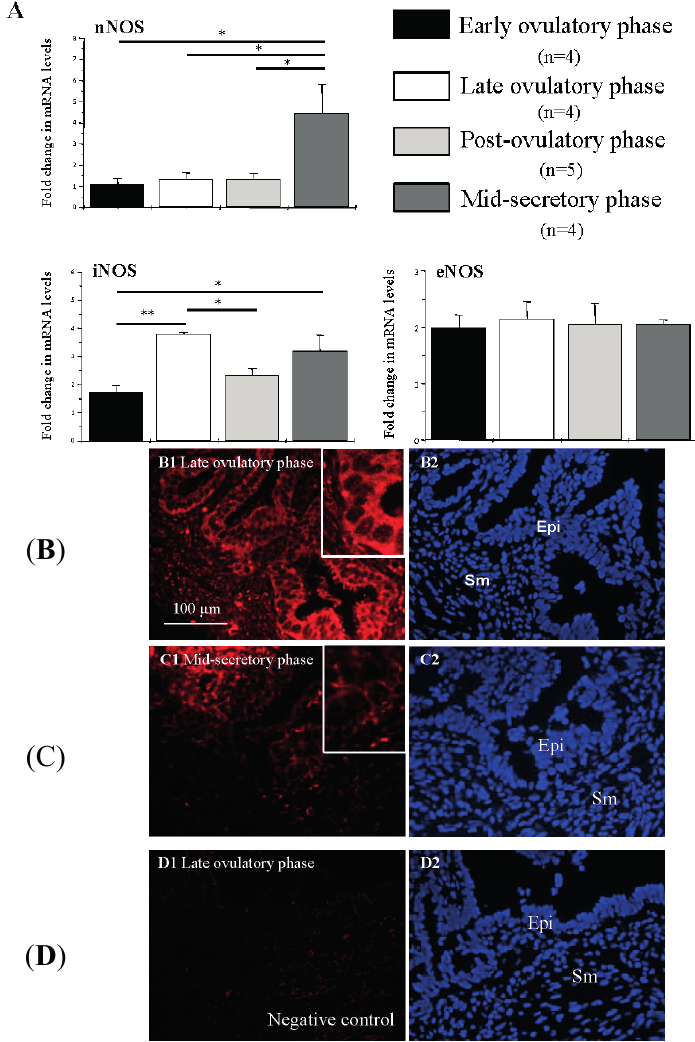
Figure 6. The mRNA and protein levels of the NOS isoforms in human Fallopian tubes. ( A ) Fold changes in nNOS, iNOS, and eNOS mRNA levels at different stages of the menstrual cycle. * p < 0.05, ** p < 0.01; ( B , C ) iNOS expression in late ovulatory phase and middle secretory phase. Slides were subsequently counterstained with DAPI to visualize the cell nuclei. Sections were immunolabeled for iNOS (red) and DAPI (blue). iNOS was found both in the epithelial cells and muscle cells of the human Fallopian tube and was located in the cytoplasm of the epithelial cells. The amount and density of iNOS expression in the late ovulatory phase was higher than in the mid-secretary phase; and ( D ) Negative control using goat serum instead of primary antibody resulted in no immunostaining. Epi, epithelial cells; Sm, smooth muscle cells. Scale bar = 100